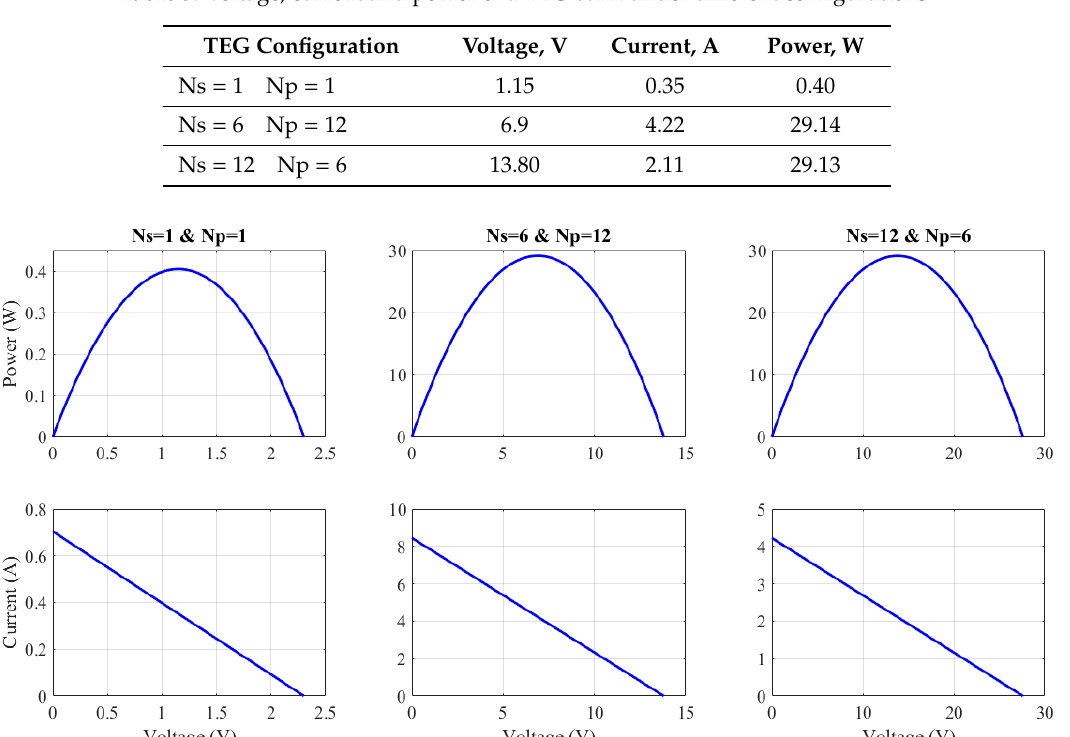
Table 5. Voltage, current and power of a TEG bank under di ff erent configurations.